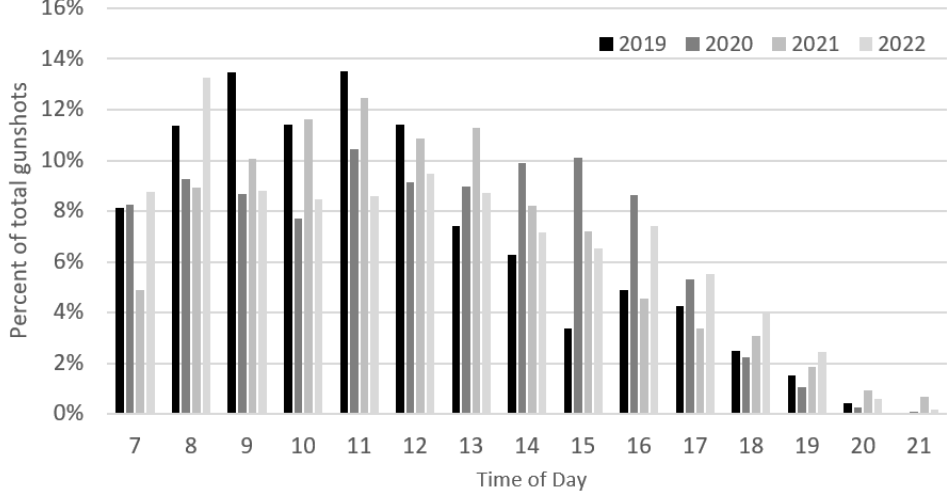
Figure 5. Diel poaching pattern during the 2019–2022 spring migrations (n = 54,014). Data were only recorded from 7 am to 10 pm.